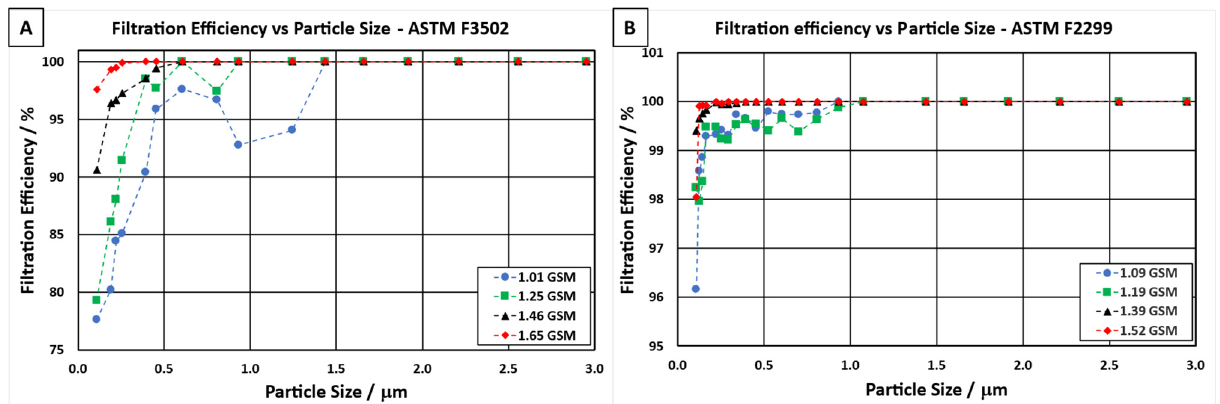
Figure 6. Filtration efficiency of filter media containing different NF areal weights vs. particle size when tested in accordance with different international standards: ( A ) ASTM F3502 and ( B ) ASTM F2299.